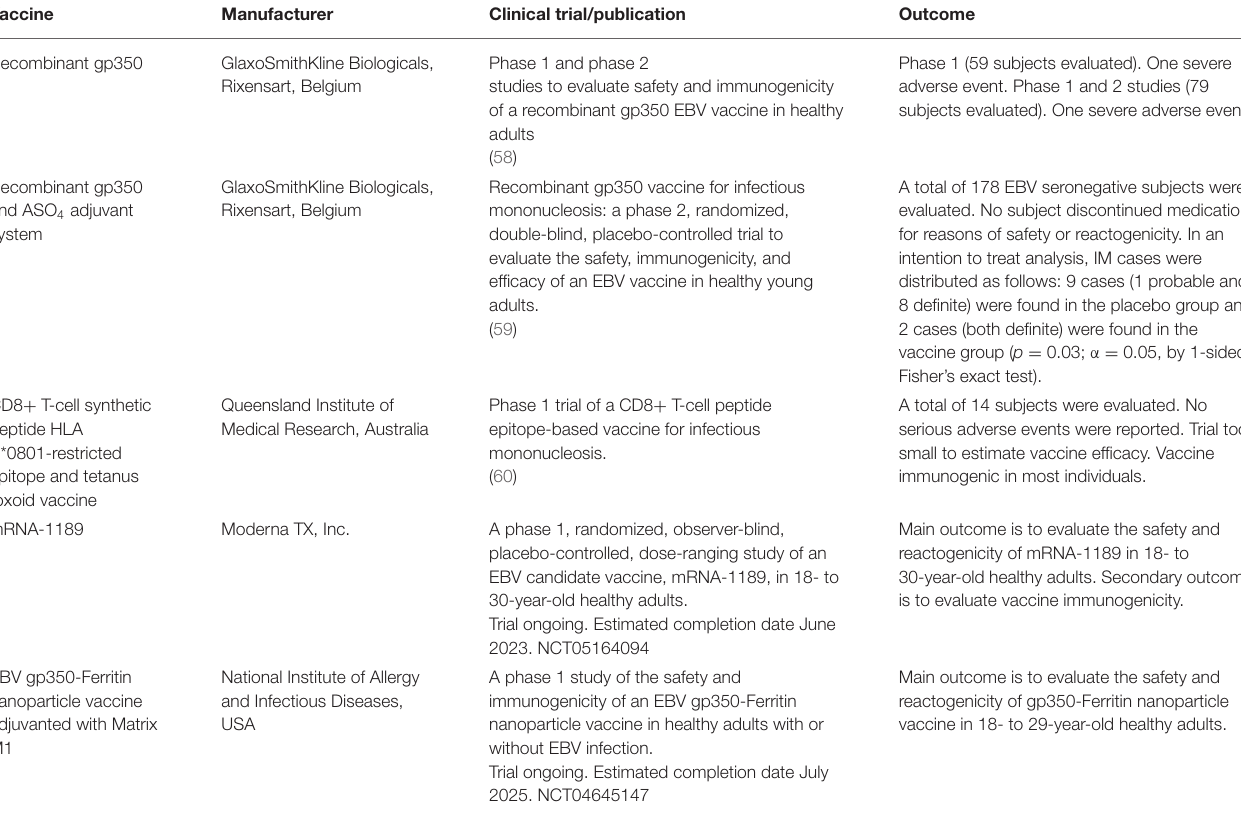
TABLE 2 | Epstein-Barr virus prophylactic vaccine clinical trials: past and present a